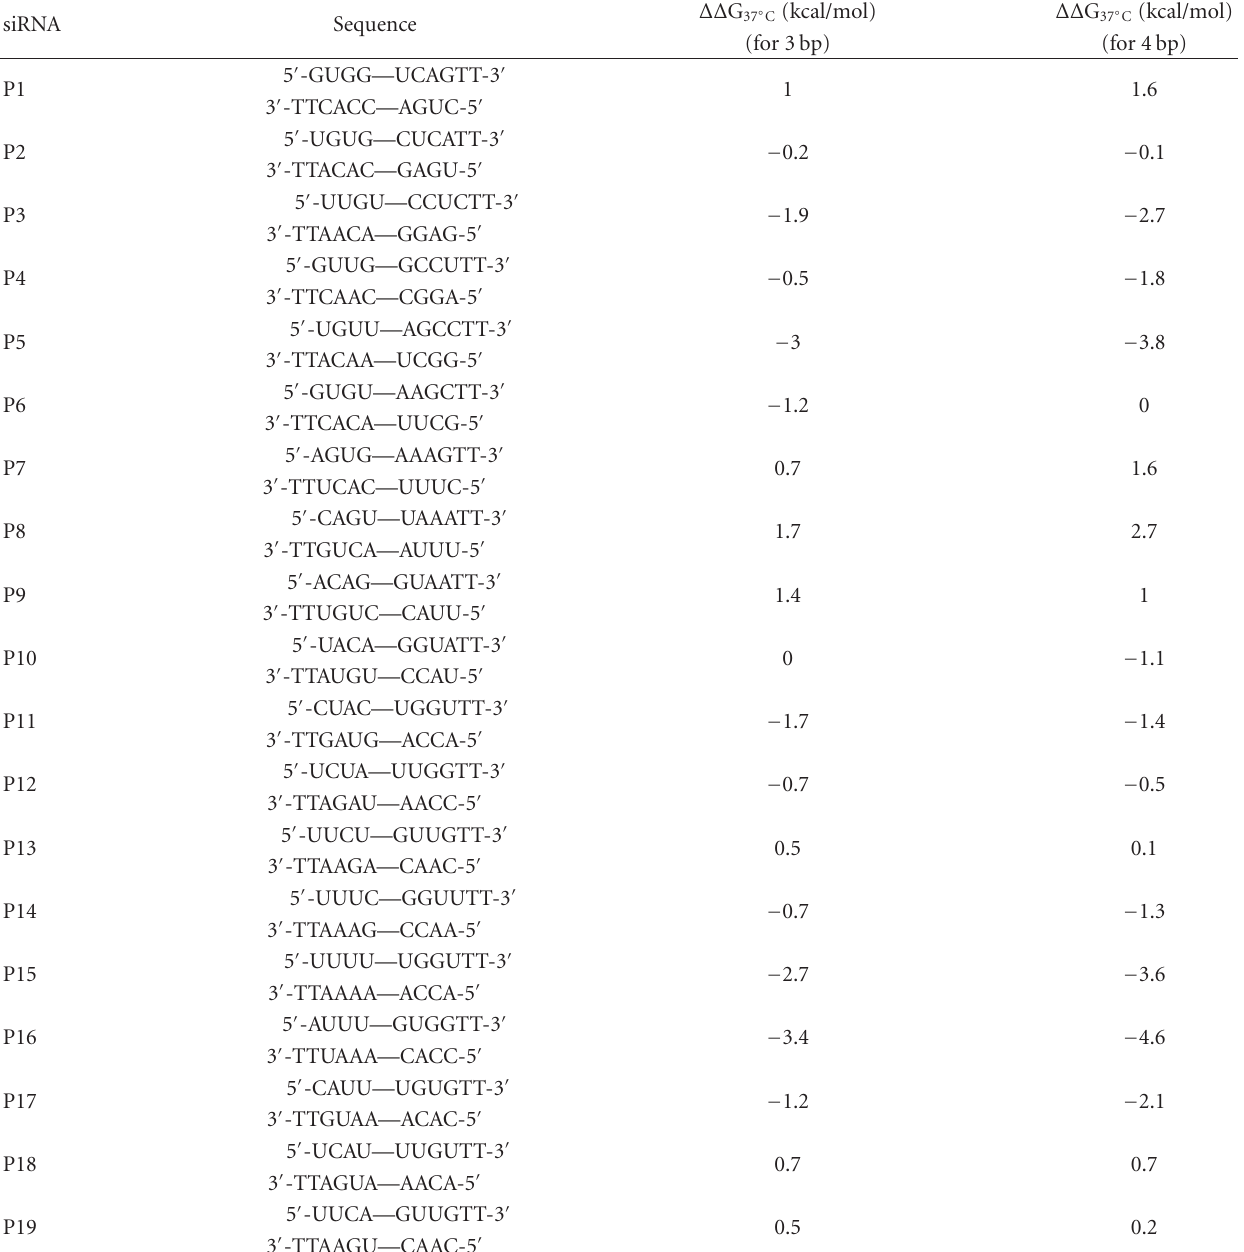
Table 2: Di ff erences between the free Gibbs energy of 5 (cid:3) -end and 3 (cid:3) -end of the duplex (resp. to the polarity of the antisense strand), calculated independently for three and for four consecutive base pairs shown for each duplex ( ΔΔ G 37 ◦ C = Δ G 37 ◦ C (5 (cid:3) -end) − Δ G (cid:3) -end)). The values of Δ G 37 ◦ C (3 37 ◦ C were calculated according to [60].